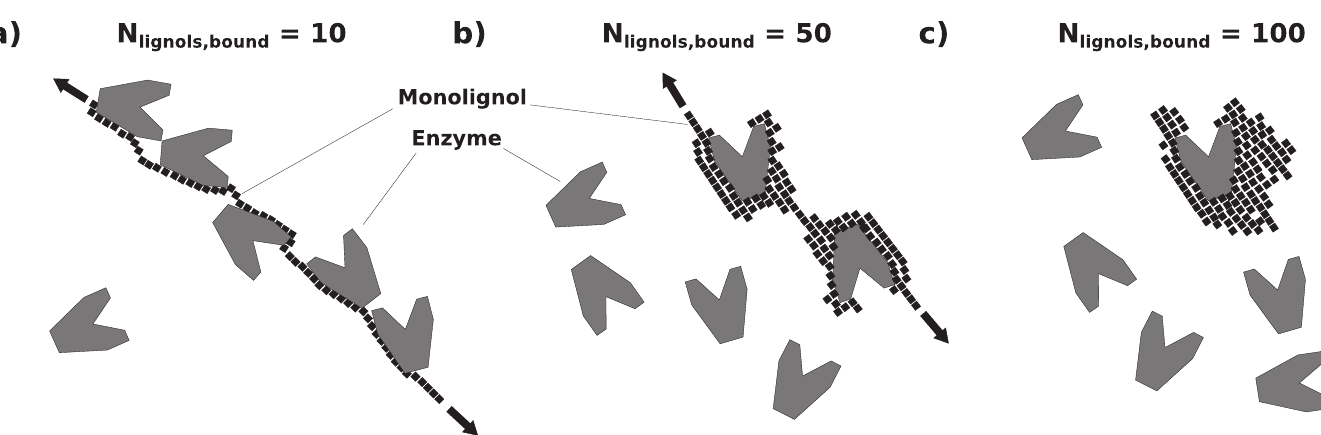
Fig 4. Sketch of the impact of N lignols,bound (the number of monolignols involved in binding per bound enzyme) on the total number of enzymes that can be bound. Starting at low values of N lignols,bound in (a), many enzymes can be bound to a single lignin polymer. As N lignols,bound increases in (b) and (c), this number steeply drops, finally reaching the limit of only a single enzyme being